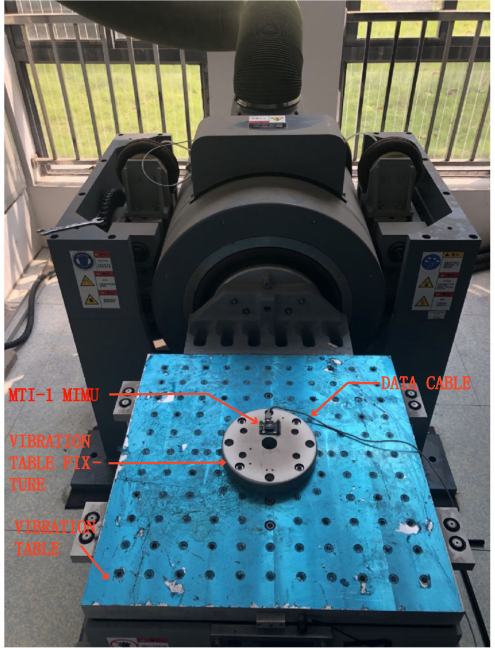
Figure 2. The experimental